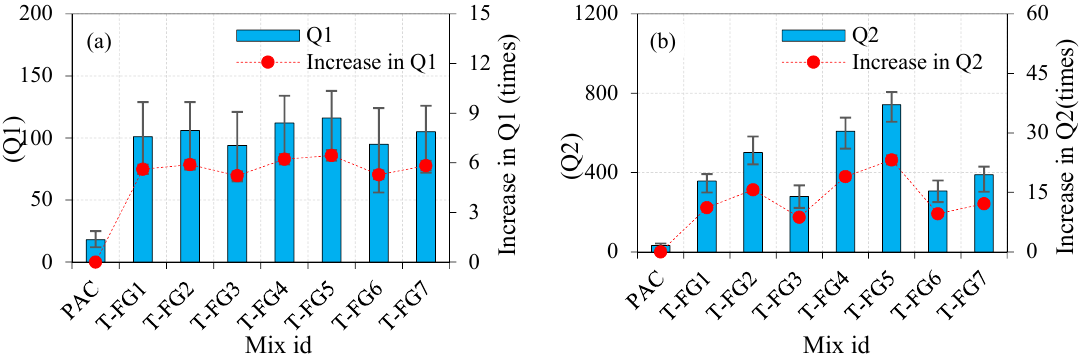
Figure 10. The effect of the triple-layered specimen on impact strength ( a ) Q1 ( b ) Q2. All FTSFC specimens exhibited an excellent impact resistance compared to the PAC specimens. The highest Q1 and Q2 values were recorded for the T-FG5 specimen. This was due to the higher dosage of SF provided in the top and bottom layers, which increased the tensile strength of these layers. As a result of the compressive waves reflected pro- duced by the falling mass, these layers could resist a more significant number of tensile waves formed at the specimen’s top surface. The ductile FTSFC specimen was designed to withstand massive tensile-stress waves mainly in the upper and bottom layers while also decreasing the energy wave via microcracking. Using a higher dosage of SF and PF